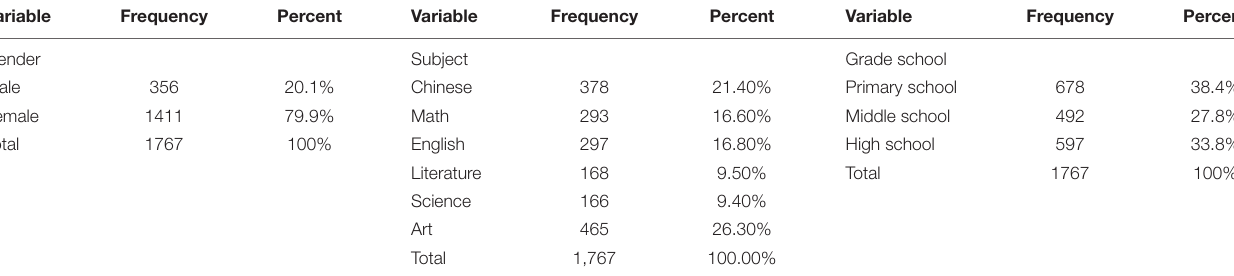
FIGURE 1 | Research model. TABLE 1 | Participants’